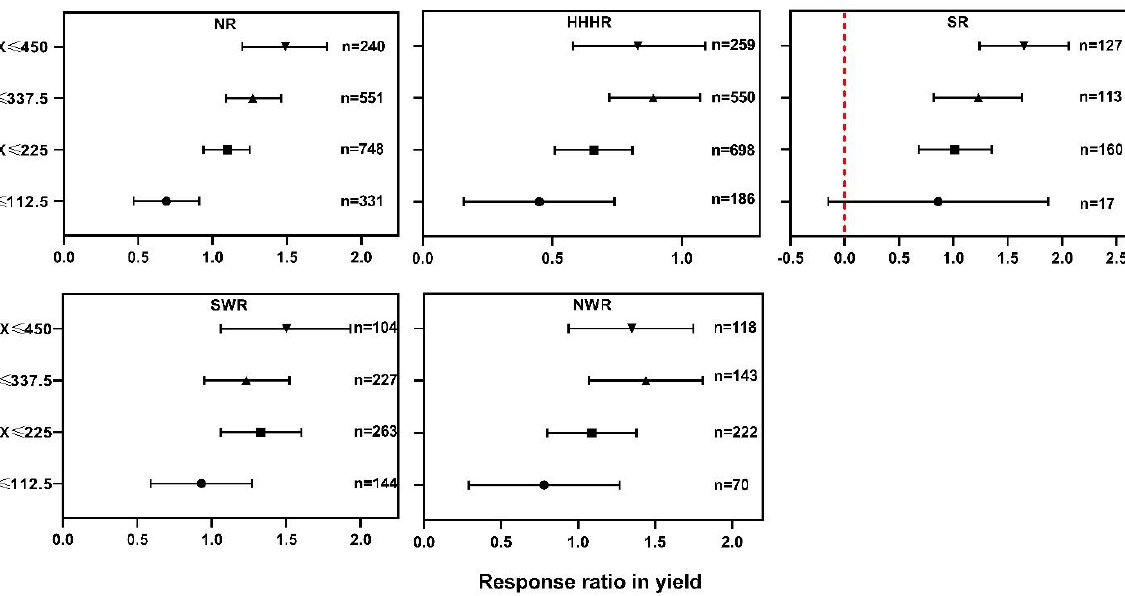
Figure 2. Relationship between maize yield and N fertilization levels in two periods ( a , b ) and comparisons between the PFPN ( c , d ) and AEN ( e , f ) of the five maize-growing regions in China. NR: Northern region; HHHR: Huang–Huai–Hai region; SR: Southern region; SWR: Southwestern region; NWR: Northwestern region. The black dashed line and red dashed line indicate the median and quartiles, respectively. ** and **** represent significance levels of p < 0.01 and p < 0.0001, respectively, and the absence of significance-level markings between any pair of regions indicates that their differences were non-significant.